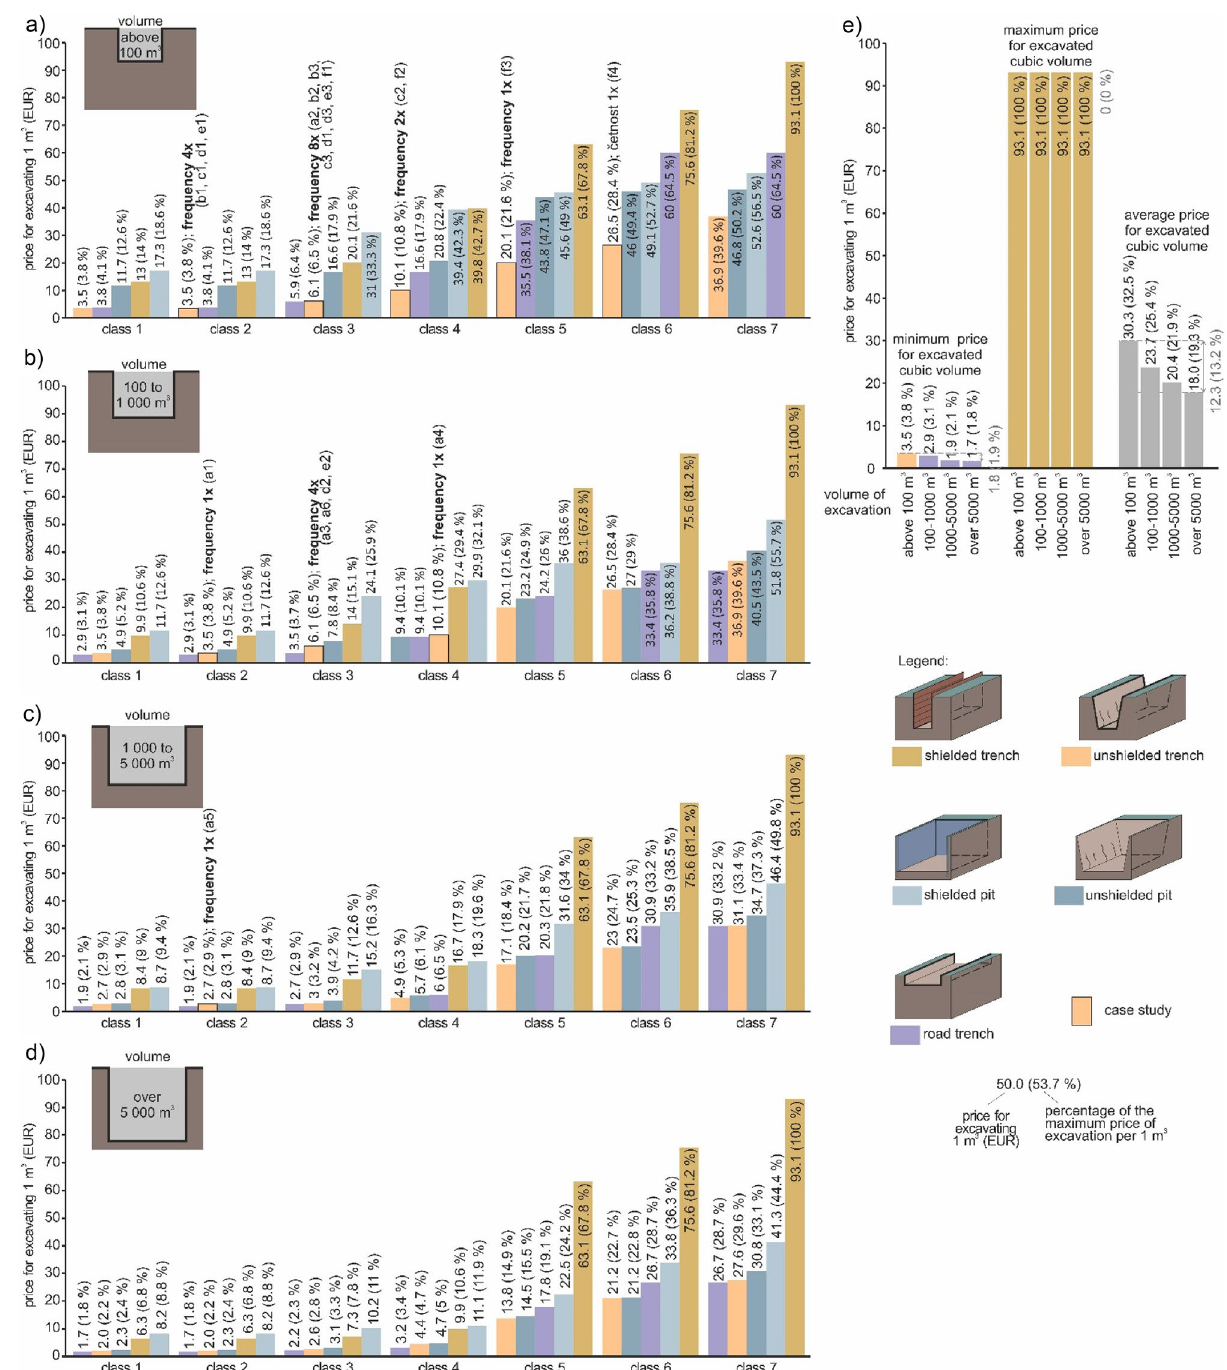
Figure 7. Graphs of assessed excavated cubic volumes; ( a ) excavated cubic volume below 100 m 3 ; ( b ) excavated cubic volume 100–1000 m 3 ; ( c ) excavated cubic volume 1000–5000 m 3 ; ( d ) excavated cubic volume over 5000 m 3 ; ( e ) maximum, minimum and average price of excavated cubic